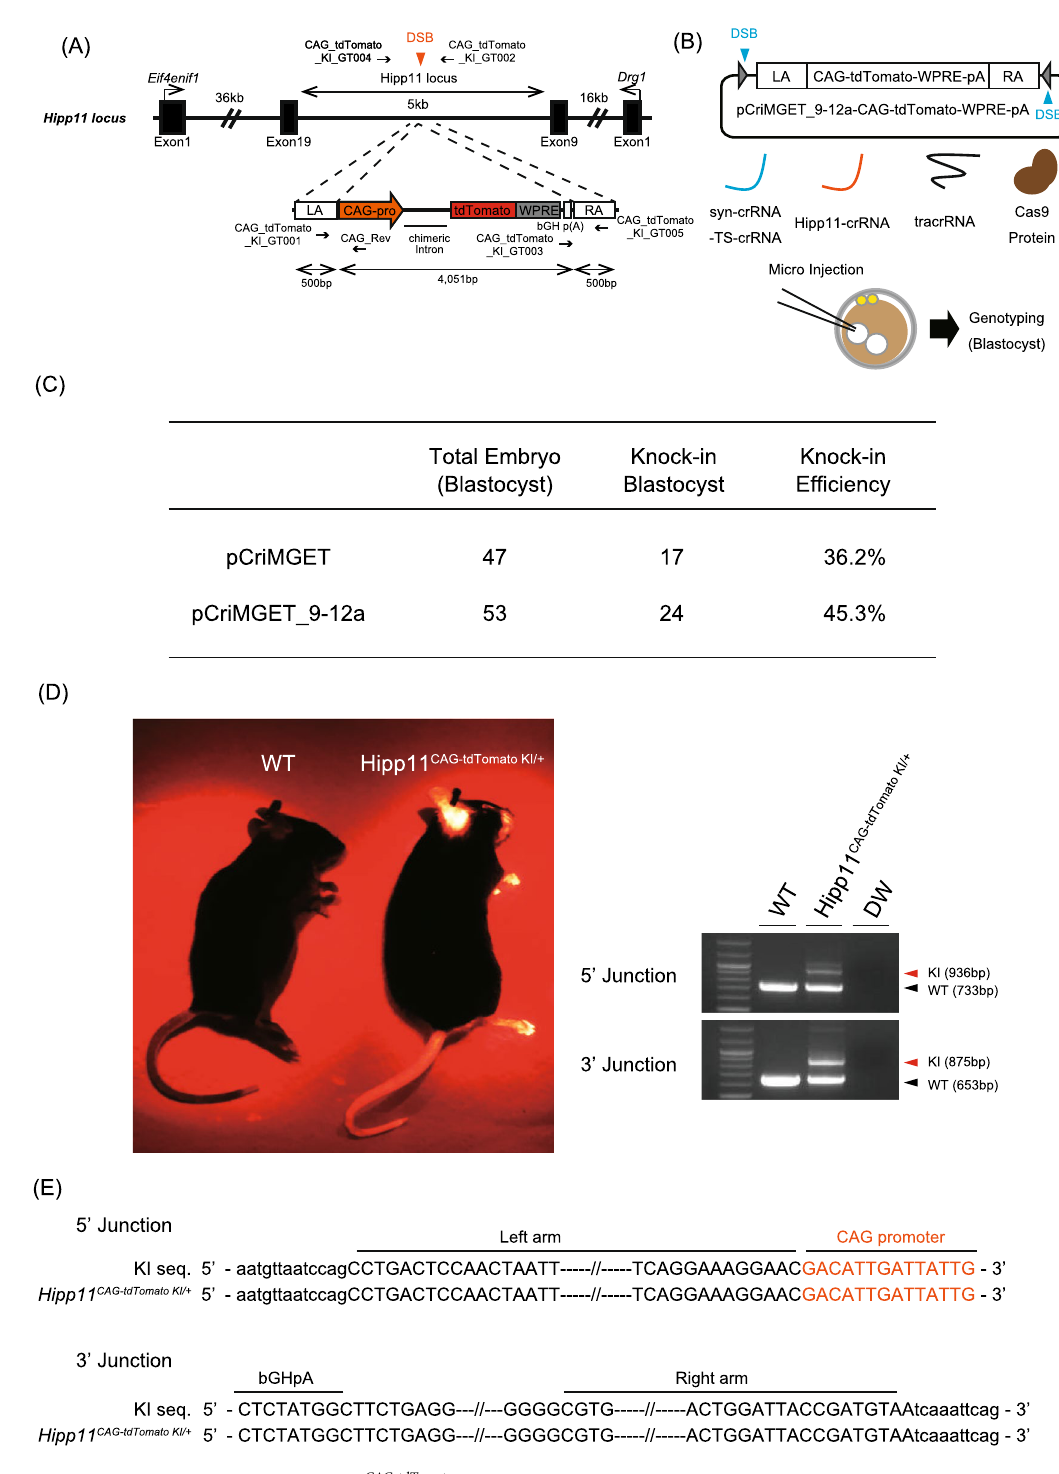
Figure 3. Generation of Hipp11 CAG-tdTomato knock-in mice by the pCriMGET_9-12a/CRISPR-Cas9 system. ( A ) pCriMGET_9-12a-mediated knock-in of the donor cassette ( CAG-tdTomato-WPRE-pA ) at the Hipp11 locus. ( B ) Generation of Hipp11 CAG-tdTomato knock-in mice by the pCriMGET_9-12a/CRISPR-Cas9 system. ( C ) Knock-in frequency of pCriMGET/CRISPR-Cas9 and pCriMGET_9-12a/CRISPR-Cas9 systems in blastocysts. ( D ) Left: tdTomato expression in wild-type (WT) and Hipp11 CAG-tdTomato KI/ + F 0 pups. Right: Genotyping PCR for WT and Hipp11 CAG-tdTomato KI/ + F 0 pups (upper, 5 ′ -junction loci; lower, 3 ′ -junction loci). PCR was performed by using CAG-tdTomato_KI_GT001, _GT002, and _GT003 primer mixture for 3 ′ -junction loci, and CAG- tdTomato_KI_GT004, _GT005, and CAG_Rev primer mixture for 5 ′ -junction loci (see ( A )). CAG_tdTomato_ KI_GT002 and _GT004 primers are annealed outside of the homology arms. KI and WT bands are indicated by red and black arrowheads, respectively. ( E ) Sequence analysis of Hipp11 CAG-tdTomato KI/ + knock-in mouse. PCR products amplified from the 5 ′ - and 3 ′ -junction regions from each knock-in mouse were sequenced. Upper- and lower-case letters indicate sequences inside and outside of the donor cassette,